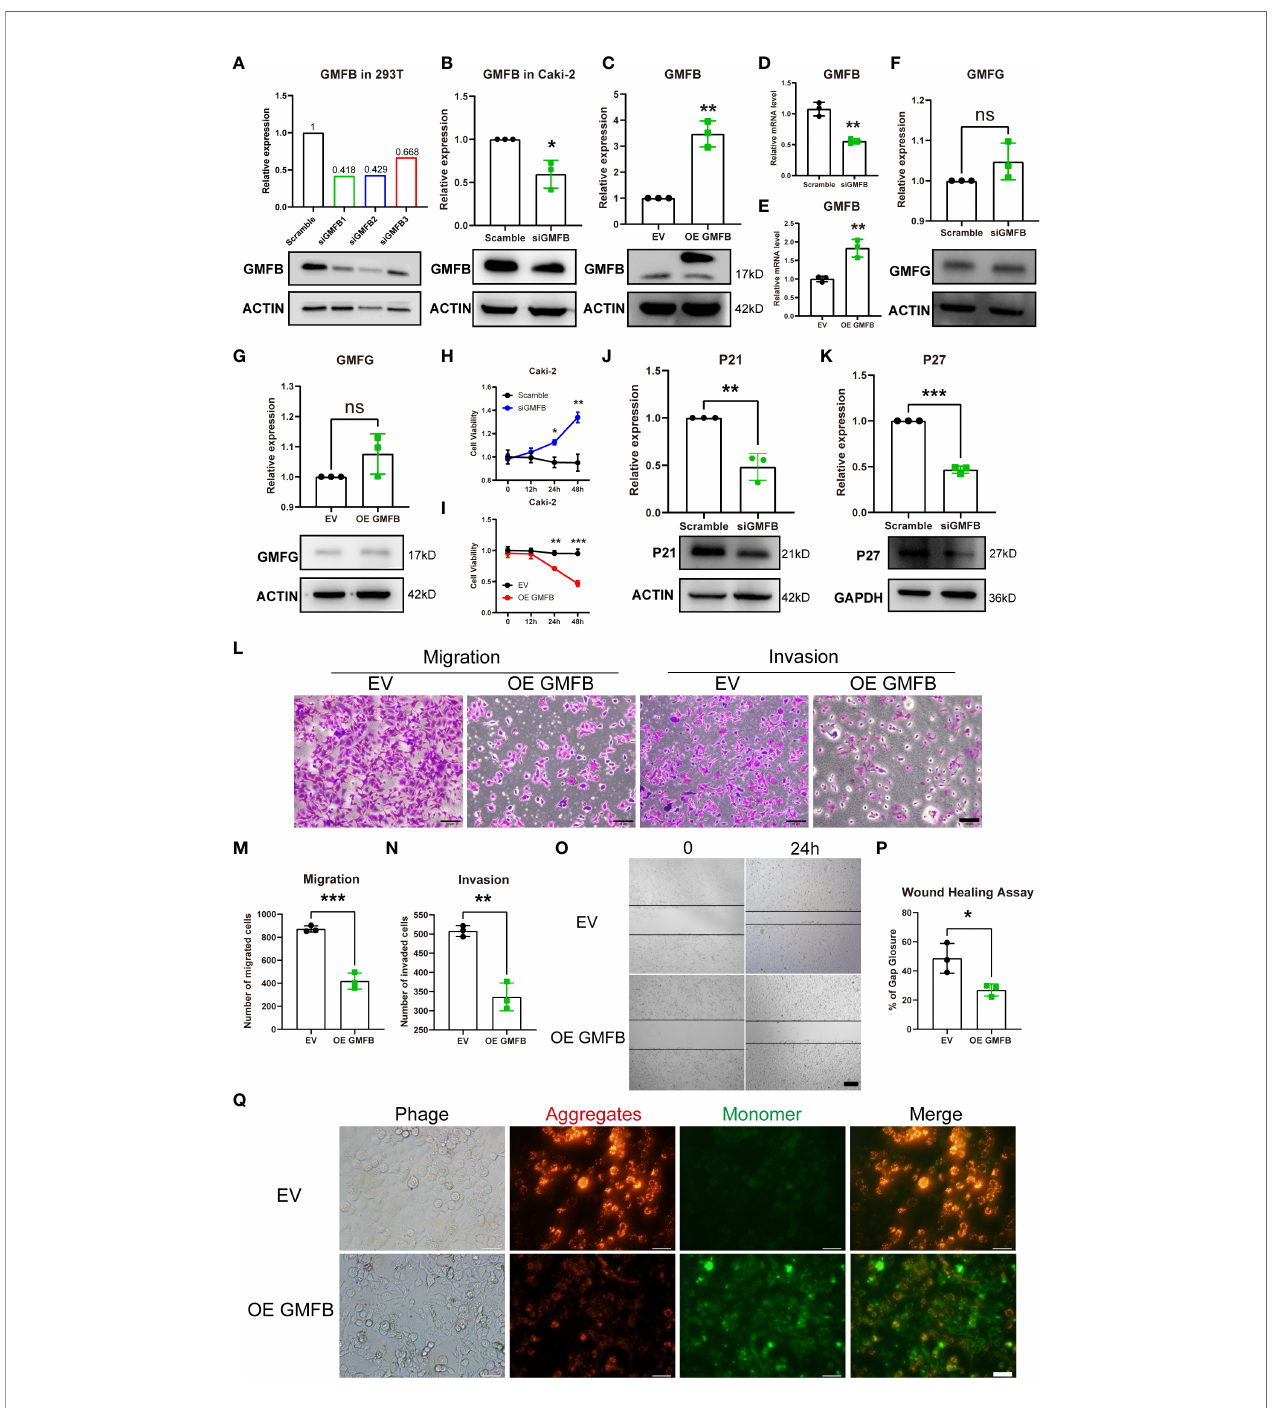
FIGURE 4 | The effects of Gmfb knockdown and Gmfb overexpression on proliferation, migration, and invasion in Caki-2 cells. (A) The knockdown ef fi ciency of three pairs of siGmfb was tested by Western blotting in HEK 293T cells. (B – E) GMFB silencing RNA and overexpression Gmfb plasmid ef fi ciency were tested by Western blotting and RT-qPCR in Caki-2 cells. (F, G) GMFG protein level was tested by Western blotting after Caki-2 cells were transferred with siRNA and overexpression plasmid of GMFB. (H, I) Cell viabilities were determined after Caki-2 cells were transferred with siRNA and overexpression plasmid of Gmfb by CCK8 assay at 12, 24, and 48(h) (J, K) The extent of the cell cycle was further determined by CDKN1A (p21) and CDKN1B (p27) using Western blotting. (L) Transwell migration and invasion assays were used to examine the migration and invasion ability of Caki-2 cells. Scale bar = 50 m m. (M, N) Quanti fi cation of migration and invasion assays. (O) Image of the scratch assay. Scale bar = 100 m m. (P) Quanti fi cation of the scratch assay. (Q) Fluorescence microscopy imaging of Caki-2 cells stained with JC-1. Scale bar = 50 m m. Error bars represent SD. *p < 0.05, **p < 0.01, ***p <